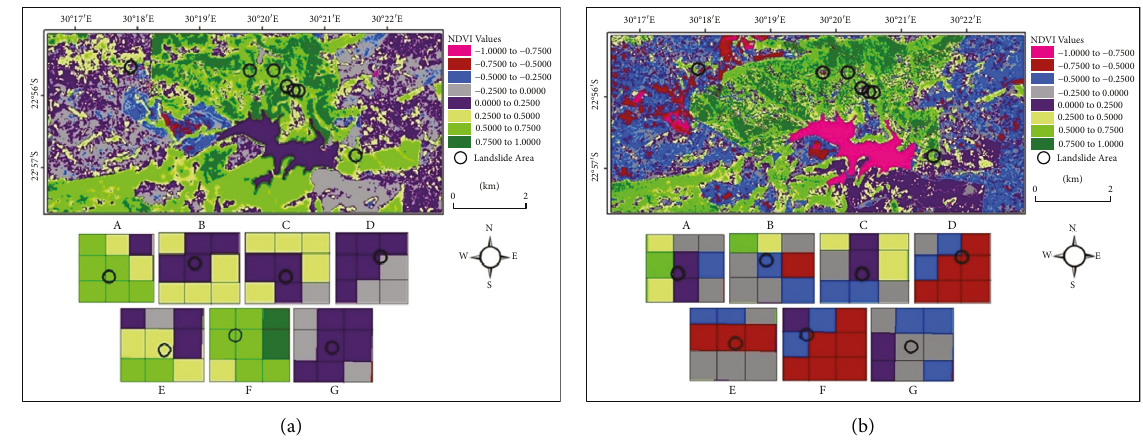
Figure 2: Maps showing the NDVI values derived from the ASTER data acquired (a) in 2004 and (b) 2007. The nine pixels, covering an area of 45m 2 , represent each slope